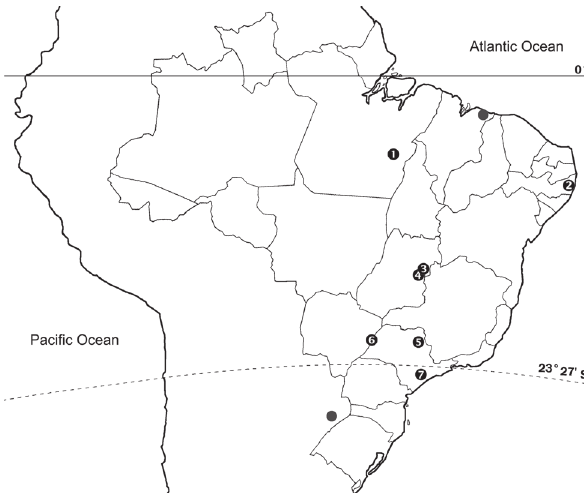
Figure 1. Distribution of Parvalona parva , showing previous ( (cid:2) ) and present records, numbered as in text. ( (cid:3) ) Serra dos Carajás, ( (cid:4) ) Apipucos Reservoir, ( (cid:5) ) Joaquim Medeiros Lagoon, ( (cid:6) ) Cedro Pond, ( (cid:7) ) pond at Aurora Farm, ( (cid:8) ) central lagoon at Paraná River, ( (cid:9) ) Japaris